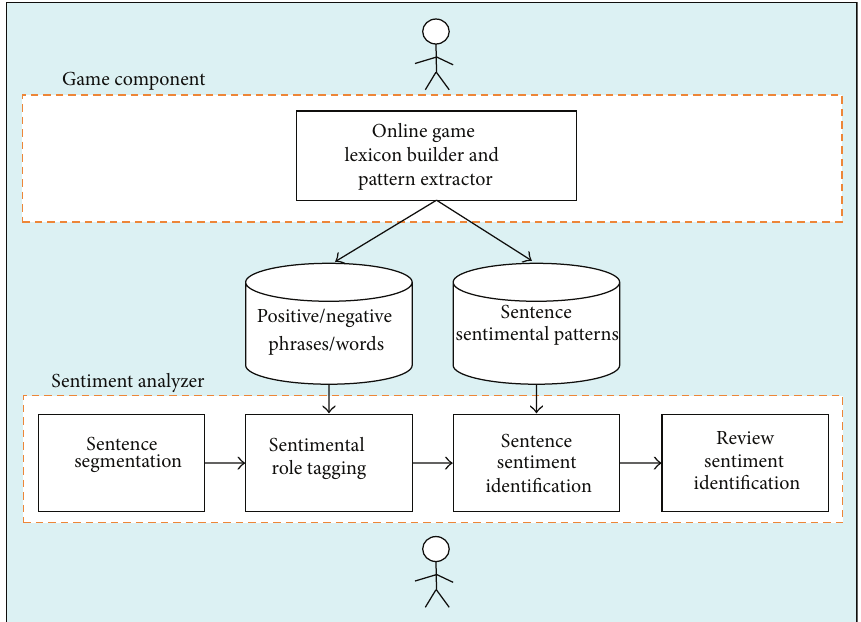
Figure 1: The architecture of our system depicting the game component and the sentiment analyzer.